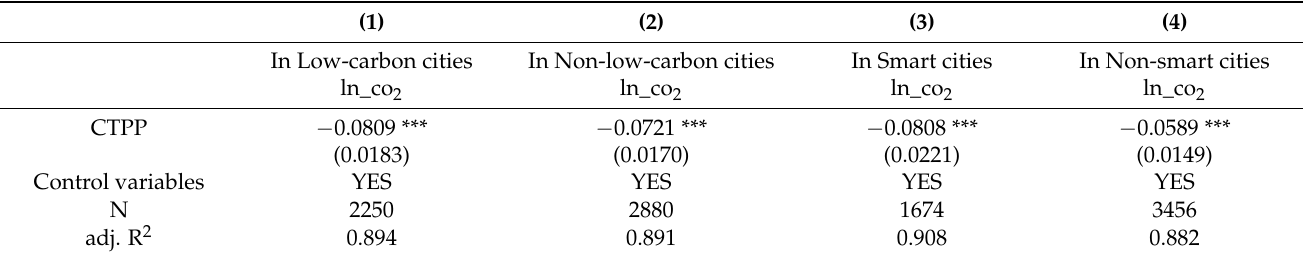
Table 7. Results of regression excluding other policy